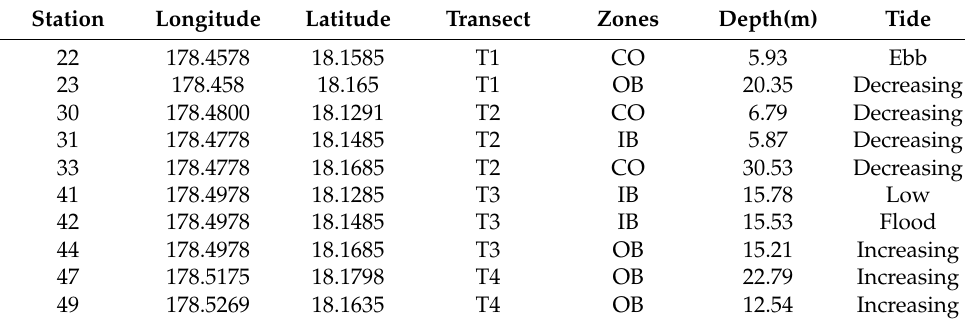
Table 1. Station locations, transects, zones, water depth, and